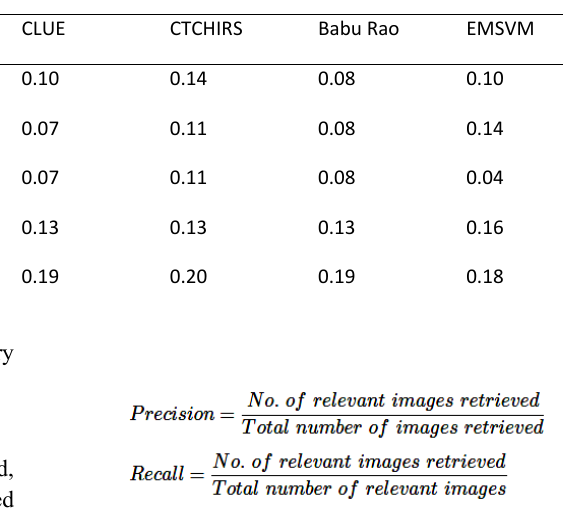
Table 2. Comparison of average recall obtained by proposed method with other standard retrieval systems Table 2. The planning and control components. [28, 6, 18, 29, 27] .